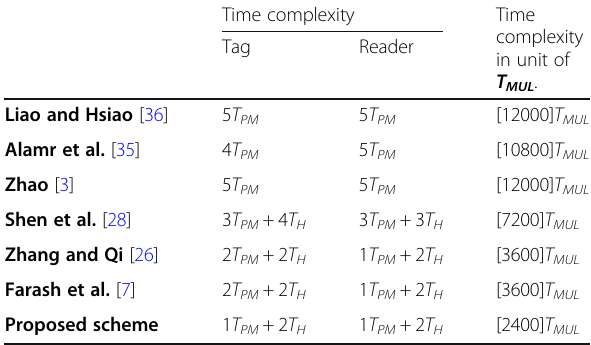
Table 5 Performance comparison computation costs